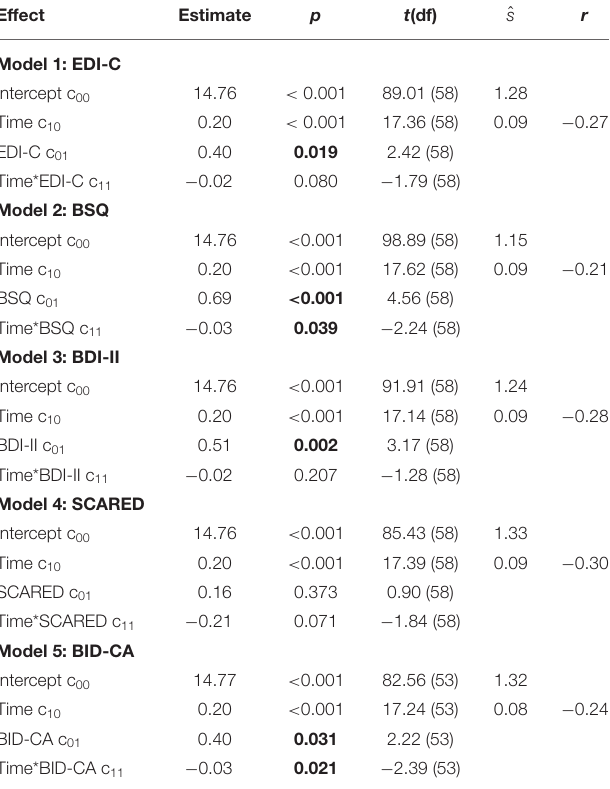
TABLE 5 | Random-intercept-random-slope-model: level-2-predictors and BMI-SDS. Effect